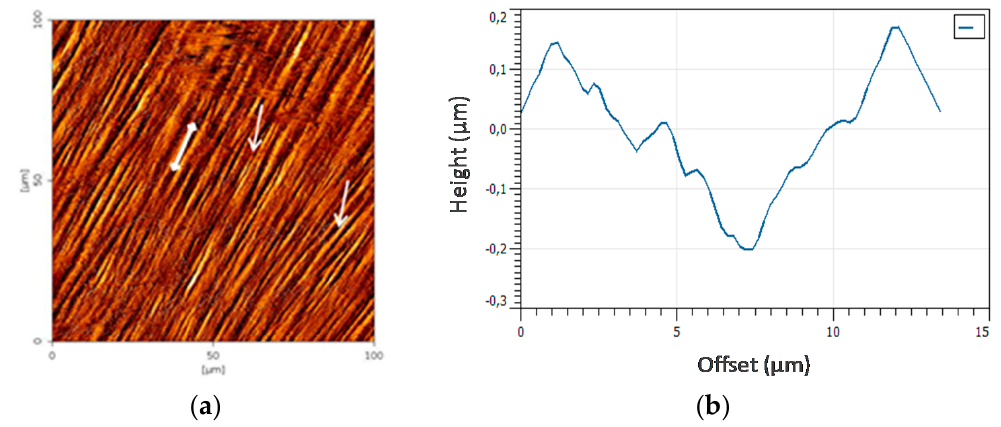
Figure 6. ( a ) Map of the internal surface of a representative gilthead seabream scale; arrows point at the rifts that correspond to the impression of circuli from the other side. ( b ) Profile obtained along the white line in ( a ), where the depression caused by the presence of circuli from the other side can be appreciated.